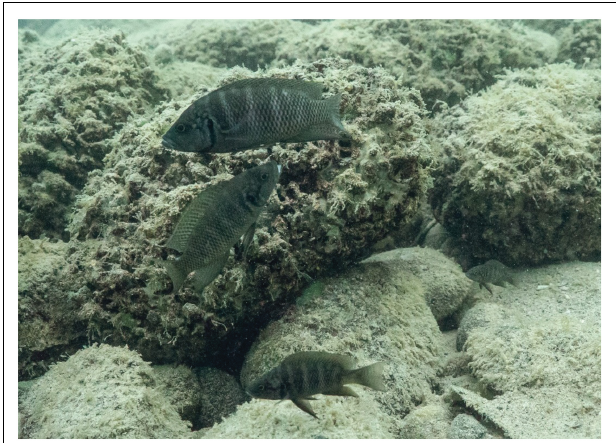
FIGURE 1 | A breeding group of Neolamprologus savoryi consisting of a breeder male (largest fish on top), a breeder female (second largest fish below), as well as one large and one small helper of unknown sex. The group defends the female’s sub-territory, with the main shelter being under the rock in the centre of the